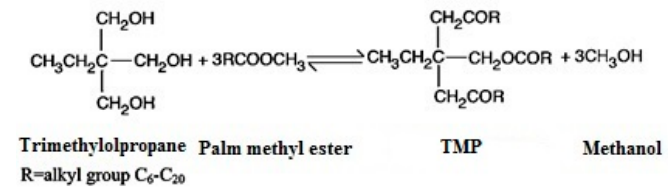
Figure 1. Chemical equation governing TMP synthesis. Table 1. Physicochemical properties and formulation details of formulated and additive-free lubricants.